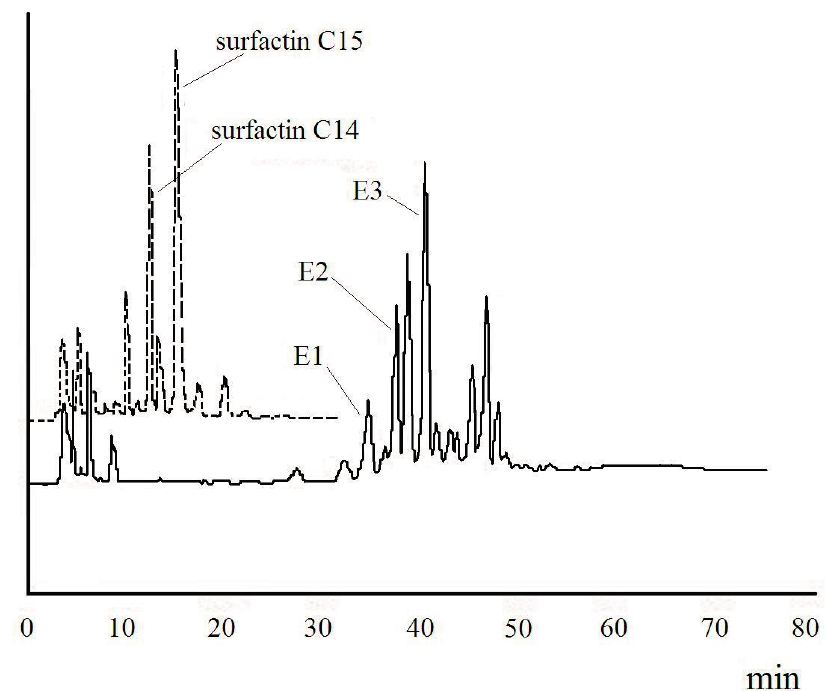
Figure 6. HPLC spectra of surfactin (dashed line) and (Glu- γ , Asp- β )-2-methoxy-ethyl-surfactin ester (solid line) under the same